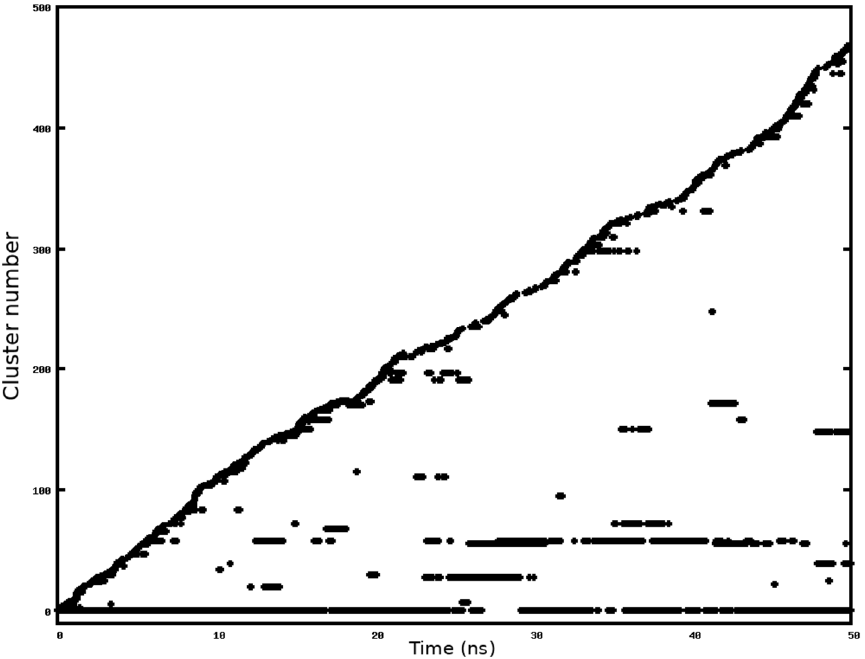
Figure 8. Changes in cluster populations of the different KRSR peptide conformations during the REMD simulation.